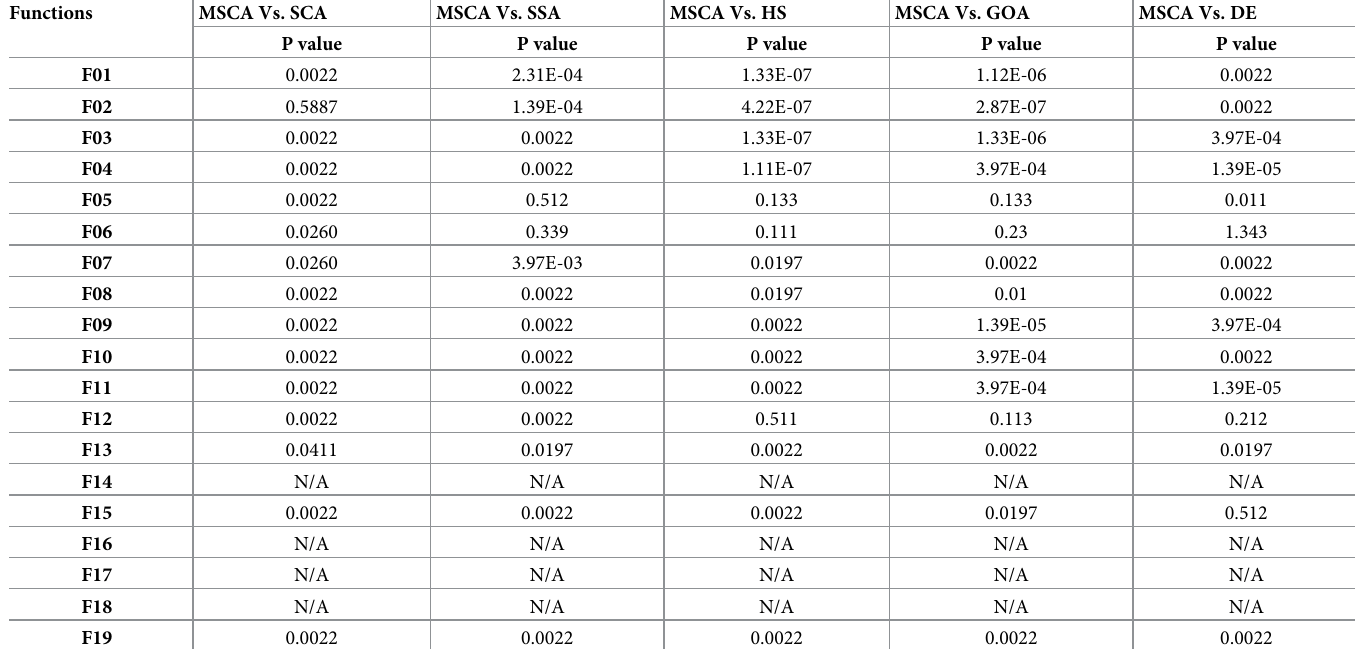
Table 7. Wilcoxon rank-sum test results over all runs. Functions MSCA Vs.